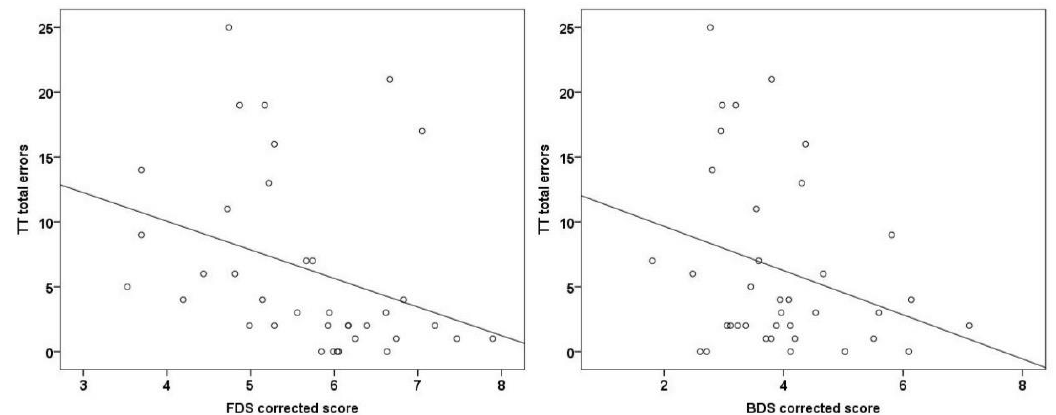
TT = Token Test. Each MoCA domain score is corrected for age, sex, and education. The TT total error distributions according to the corrected score obtained in FDS and BDS tests are presented in Figure 1.